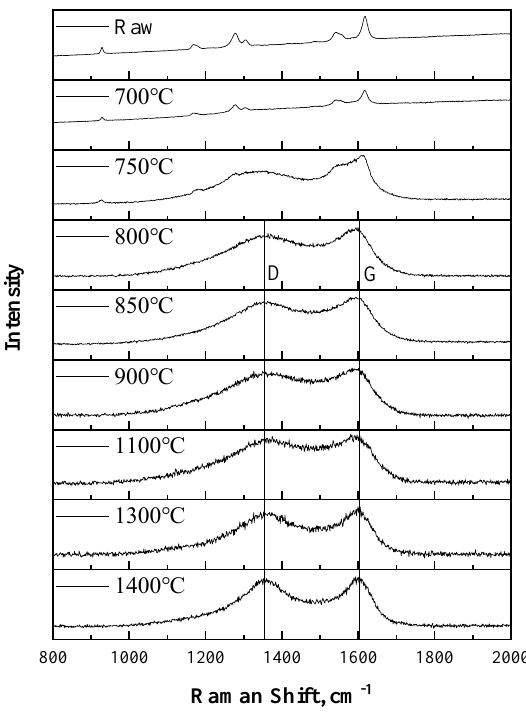
Figure 6. Raman spectra of each sample.